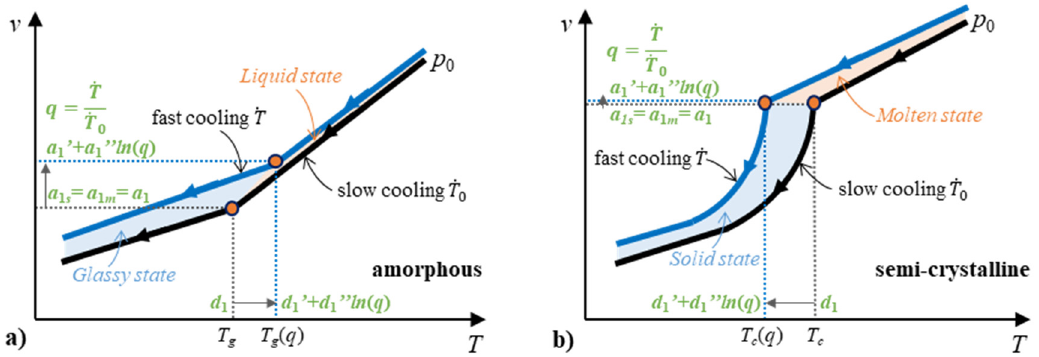
Figure 3. Schematic of the cooling rate-dependent pvT curves for amorphous ( a ) and semi-crystalline ( b ) polymers and the relative parameters for the continuous two-domain EoS considering the cooling rate.